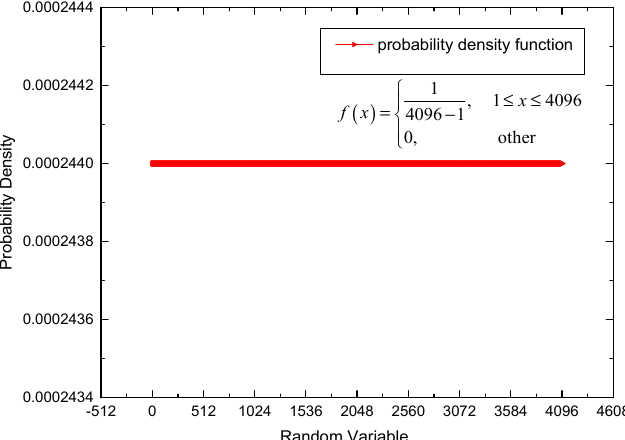
Figure 2. The probability density function of uniform distribution.